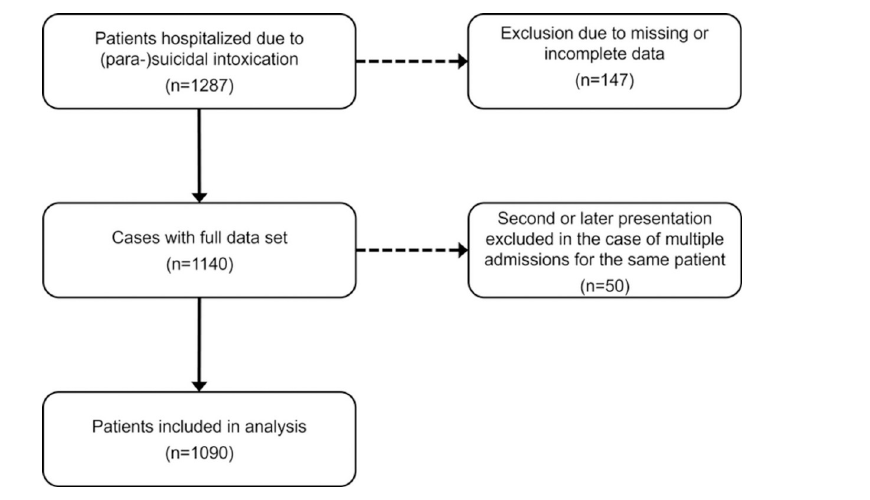
Fig 1. CONSORT diagram.